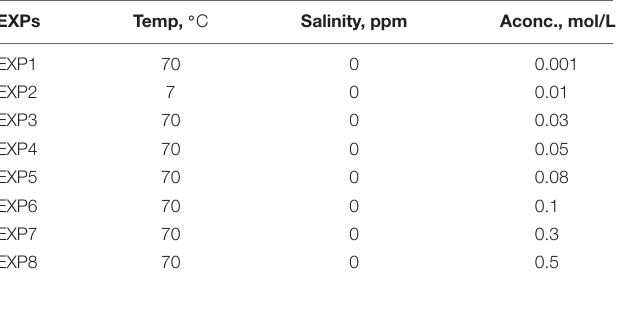
TABLE 12 | NaOH salinity trend study experiment design.